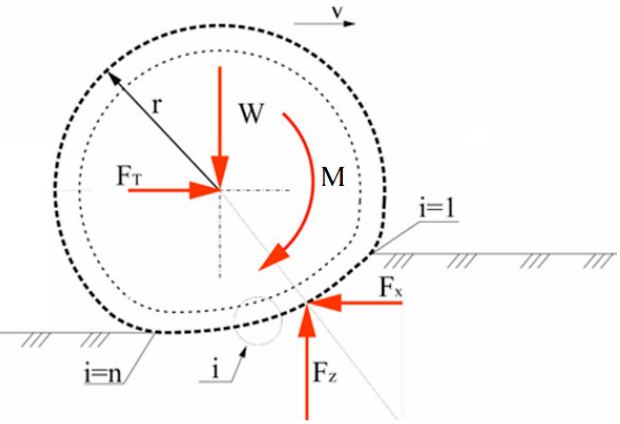
Figure 6. The forces acting on the wheel on soft surface: i—treat element; n—treat elements in contact with ground number; W—vertical load of wheel; F T —pulling force.